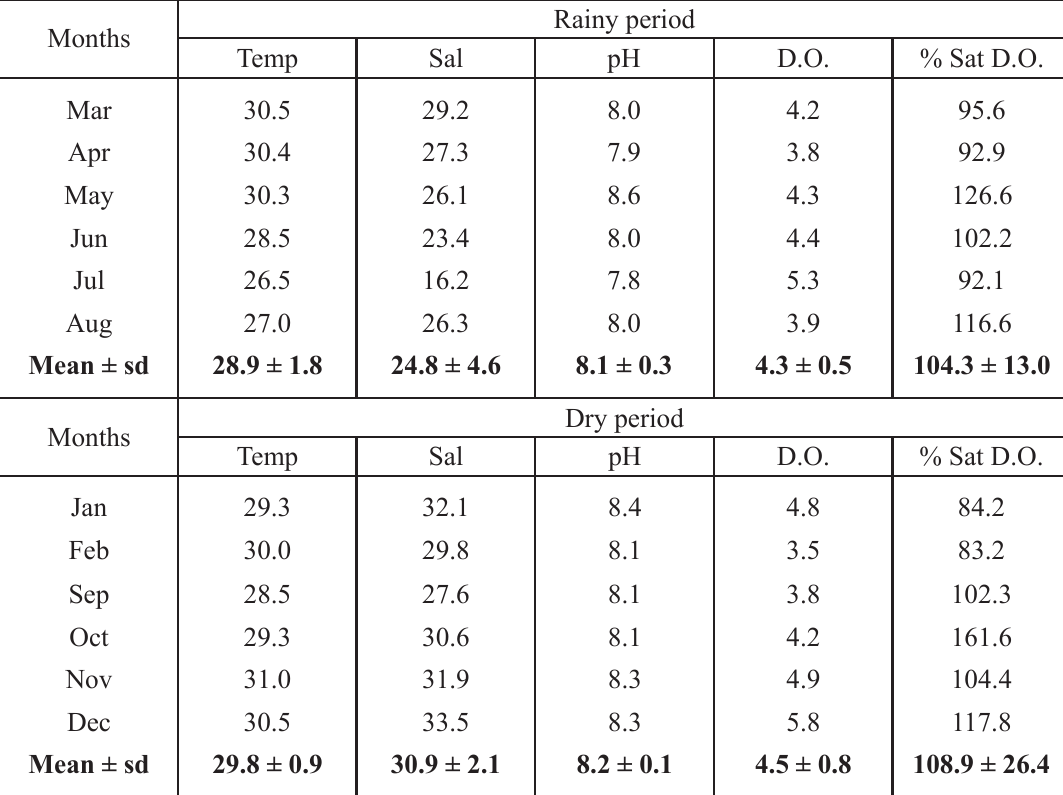
Mean monthly values of each abiotic variable at Santa Cruz Channel. Temp = temperature; Sal